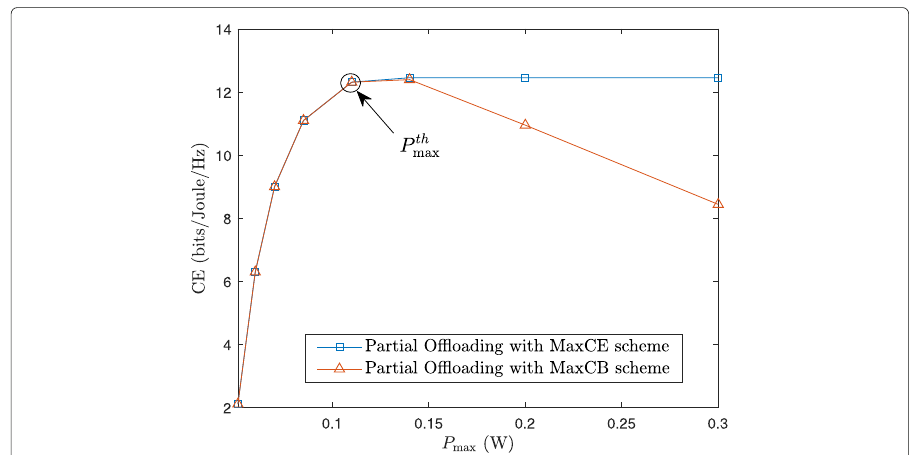
Fig. 5 Comparison of CEs under the partial offloading mode with the CE maximization scheme and the CB maximization